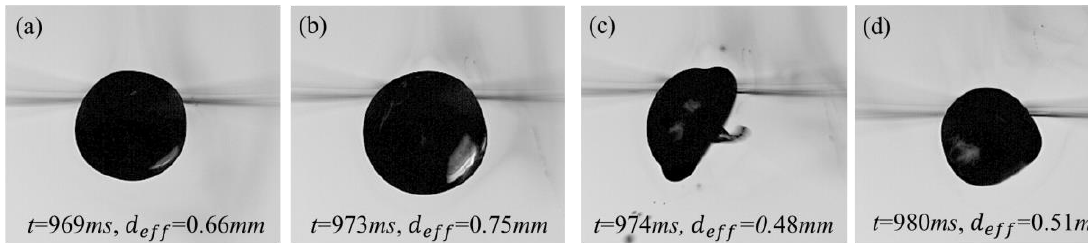
Figure 7. Microexplosion progression in a Bakken crude oil droplet, along with effective diameter, 𝑑 𝑒𝑓𝑓 (see Equation (1)). Puffing from ( a ) to ( b ), a microexplosion in ( c ), and the shrunken droplet with a smaller effective diameter in ( d ).